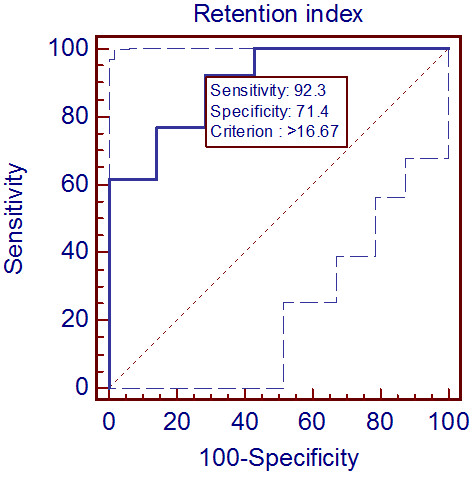
Receiver operating curve analysis of retention index. The sensitivity and specificity were calculated when the retention index cutoff value was set at 16.67.